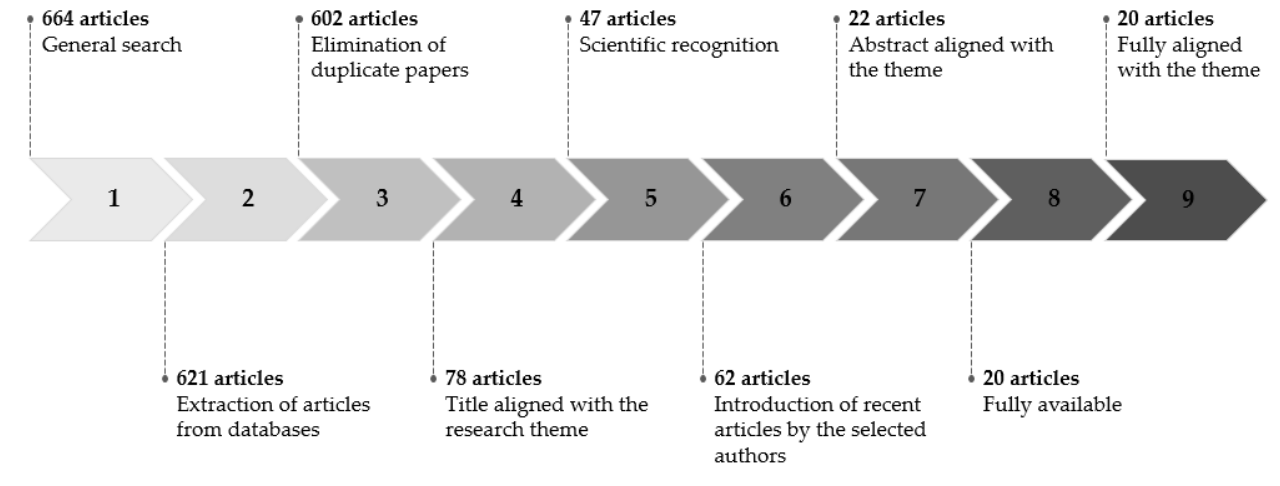
Figure 3. Stages to select the